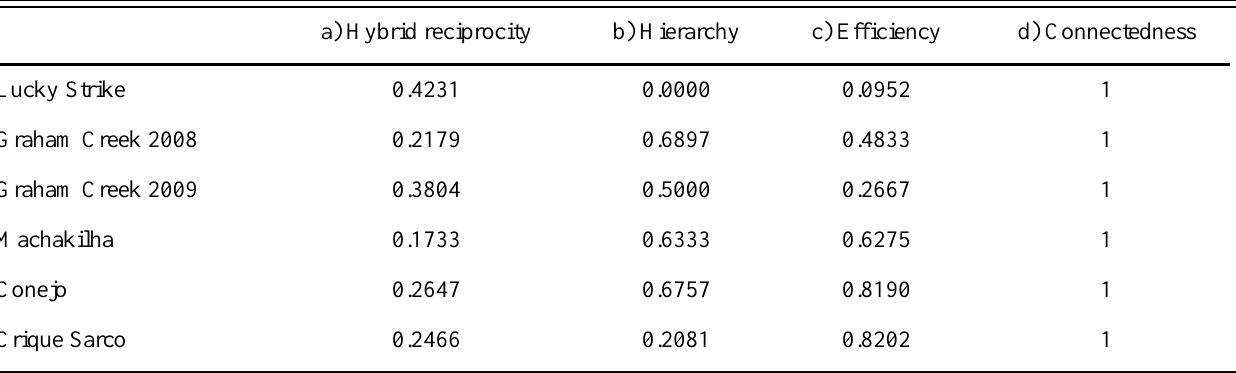
Table 3. Measurements of reciprocity and social hierarchy in Q’eqchi’ labor-exchange networks. All statistics are measured on a 0–1